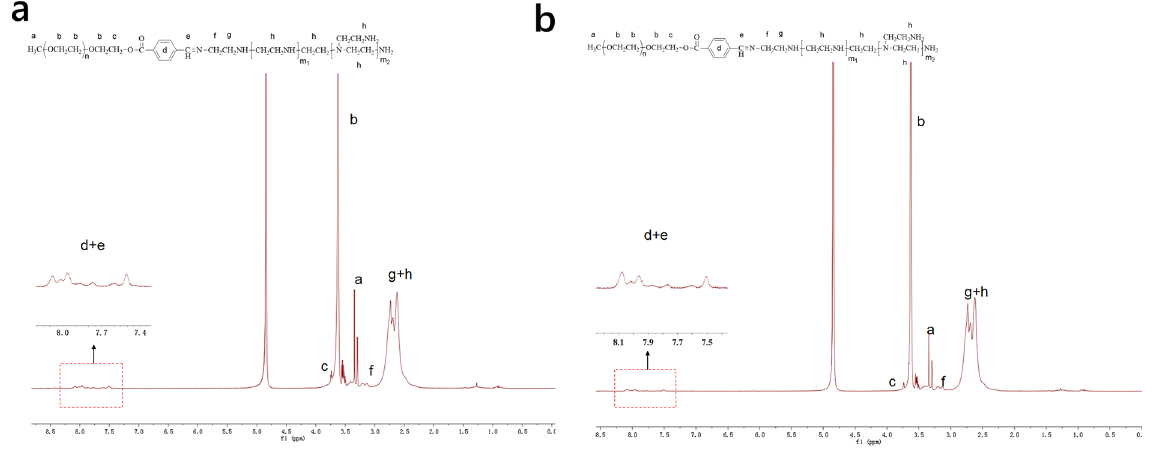
Figure 1. 1 H-NMR spectrum spectras of PEG-s-PEI-1 ( a ) and PEG-s-PEI-2 ( b ) in CH 2